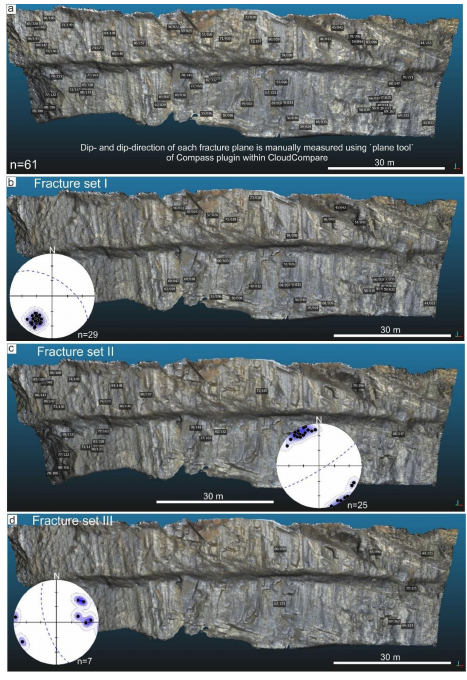
Figure 5. ( a ) Virtual structural data obtained from the 3-D model using the ‘Compass’ tool of ClouldCompare. ( b ) Orientations for fracture set I exhibit a prominent NW-SE strike and moderate dip to the NE. ( c ) Stereoplot of set II fractures striking NE-SW and very steeply dipping SE. ( d ) Fracture set III is NNW-SSE striking and steeply dipping towards the SW.